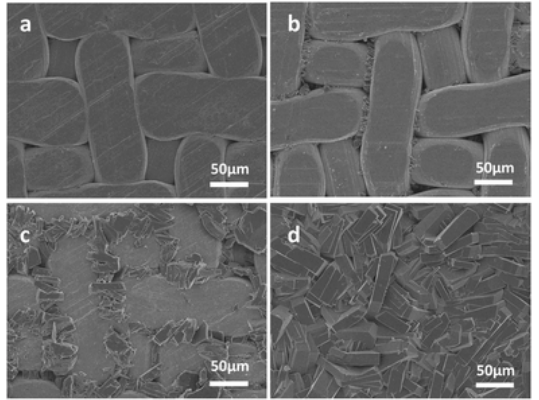
Figure 4. Top view SEM pictures of Ni 2 (L-asp) 2 (bipy) membranes grown for ( a ) 1 h, ( b ) 2 h, ( c ) 3 h, and ( d ) 4 h at 150 °C (adapted with permission from ref. [79]).